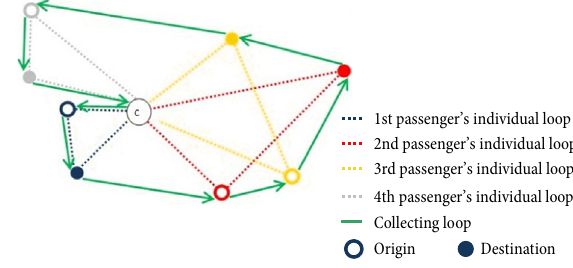
Fig. 3. The illustration of the last step of case No. 1